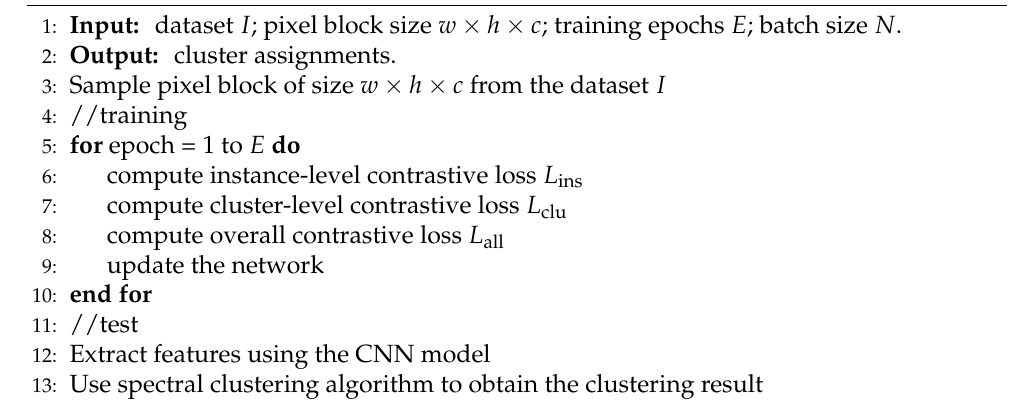
Algorithm 3 Our proposed clustering